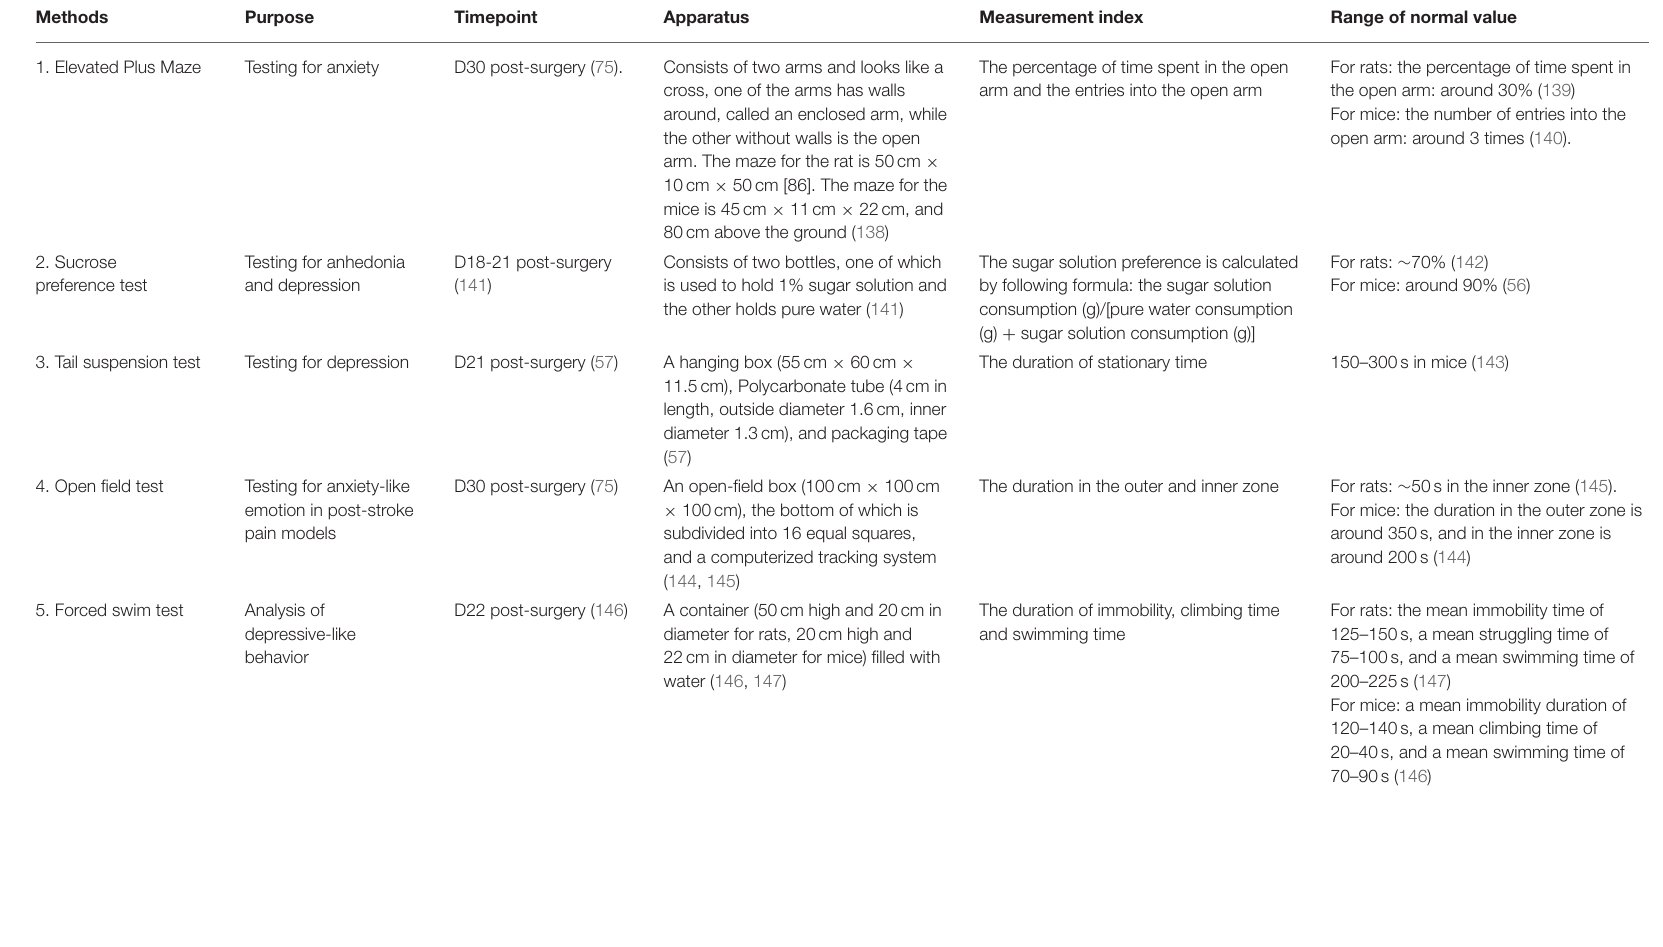
TABLE 5 | Emotion-related